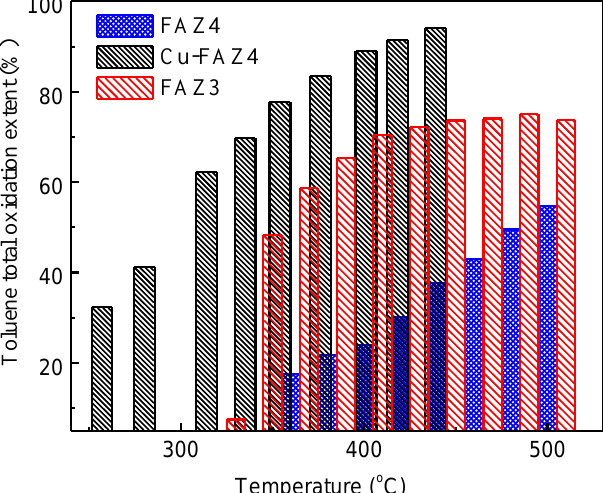
Figure 8. Toluene conversion extent at different temperatures of sonicated FAZ3, parent FAZ4 and CuO-modified FAZ4 obtained with magnetic stirring.